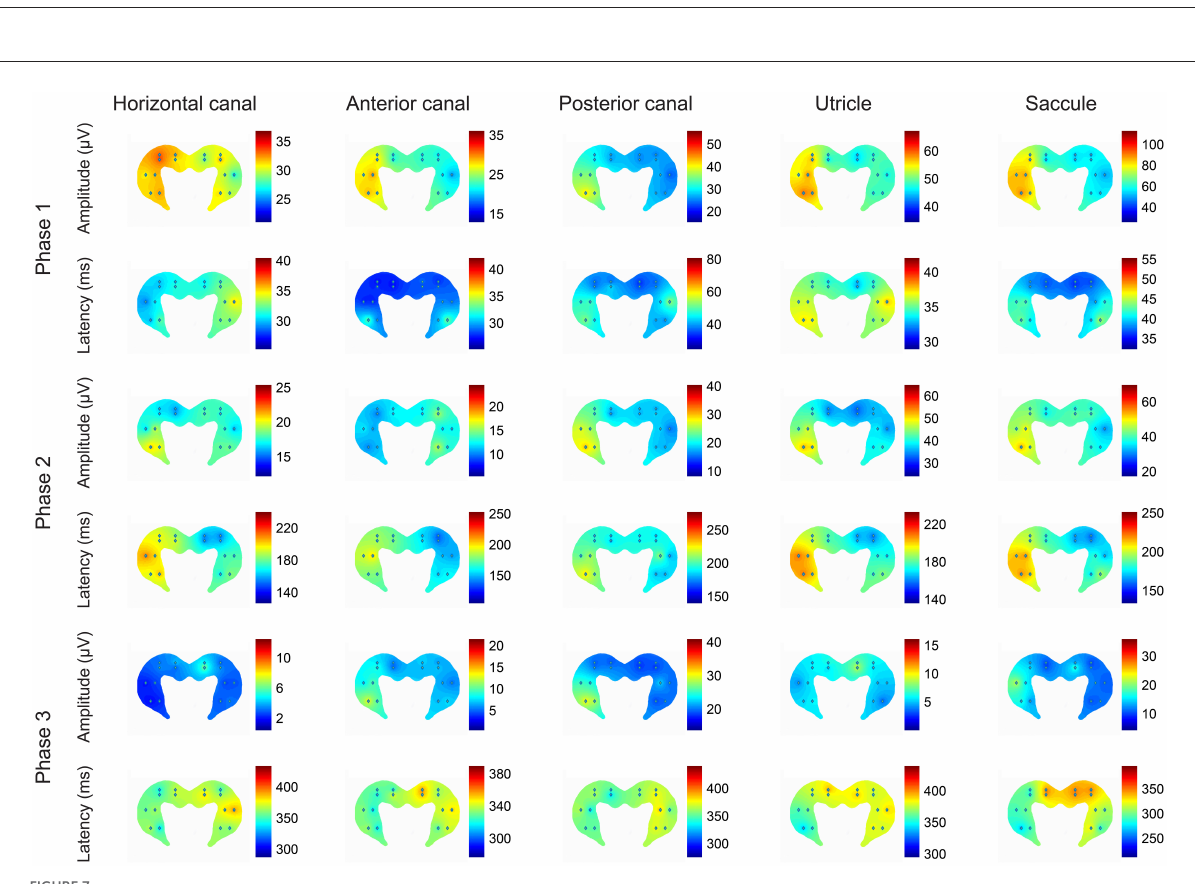
FIGURE7 Heat plots of the patterns of amplitudes and latencies of the 3 phases of the local field potentials (LFPs) evoked in the hippocampus by electrical stimulation of the horizontal canal (HC), anterior canal (AC) or posterior canal (PC) ampullae, or the utricle or saccule, where the hot colors represent the highest amplitudes and the longest latencies. The heat maps represent the data from all of the rats used in the experiments. The left side on the figures represents the right hippocampus and is contralateral to the stimulation. This is a heatmap scaled by itself, i.e., every single heatmap has maximum and minimum colors. The advantage of this heatmap is that it helps to understand how stimulation of the different sensors activates different areas of the hippocampus. The stimulus used was 300 µ A at 400Hz in all cases. Reproduced with permission from Hitier et al.